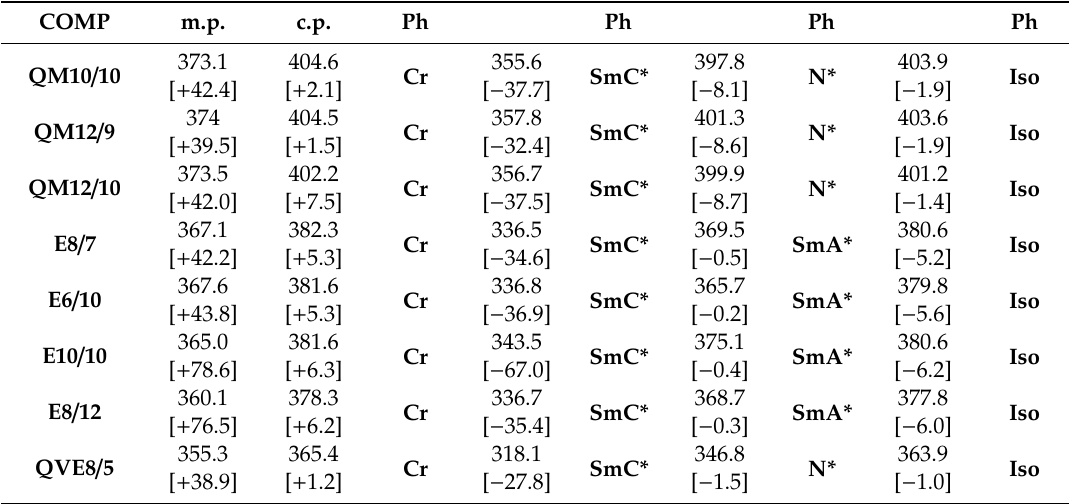
Table 2. Phase (Ph) and their transition temperatures including melting points (m.p.) and clearing points(c.p.) in Kelvin and the corresponding enthalpy values in Jg − 1 measured on cooling during 2nd DSC cycle (5 Kmin − 1 ) for all of the investigated